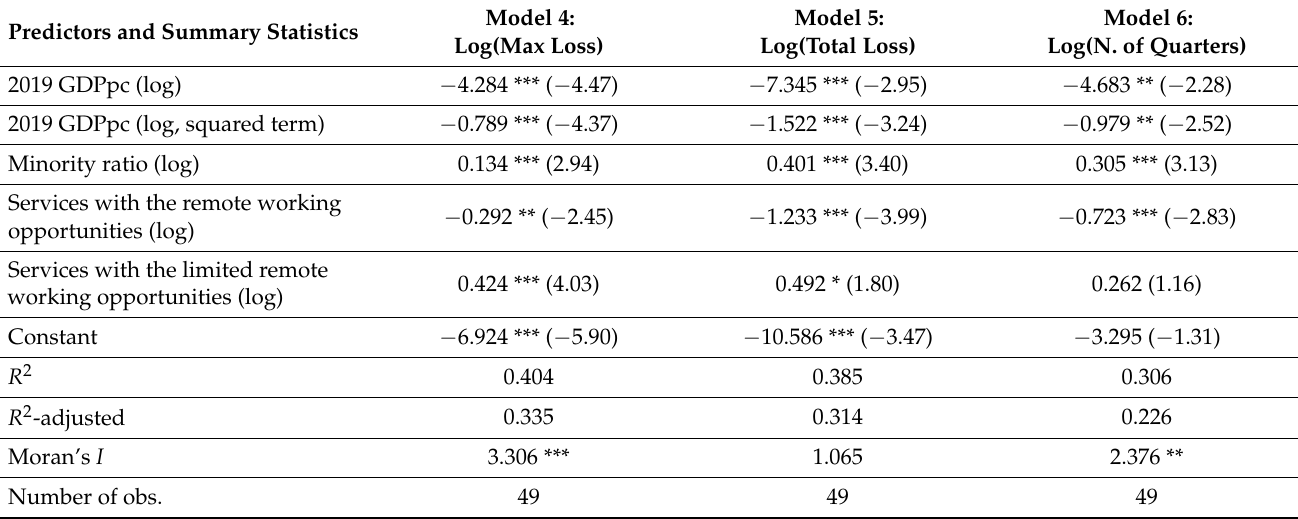
Table 2. Association between the magnitude of the economic losses and socioeconomic characteristics of the states (model type: linear